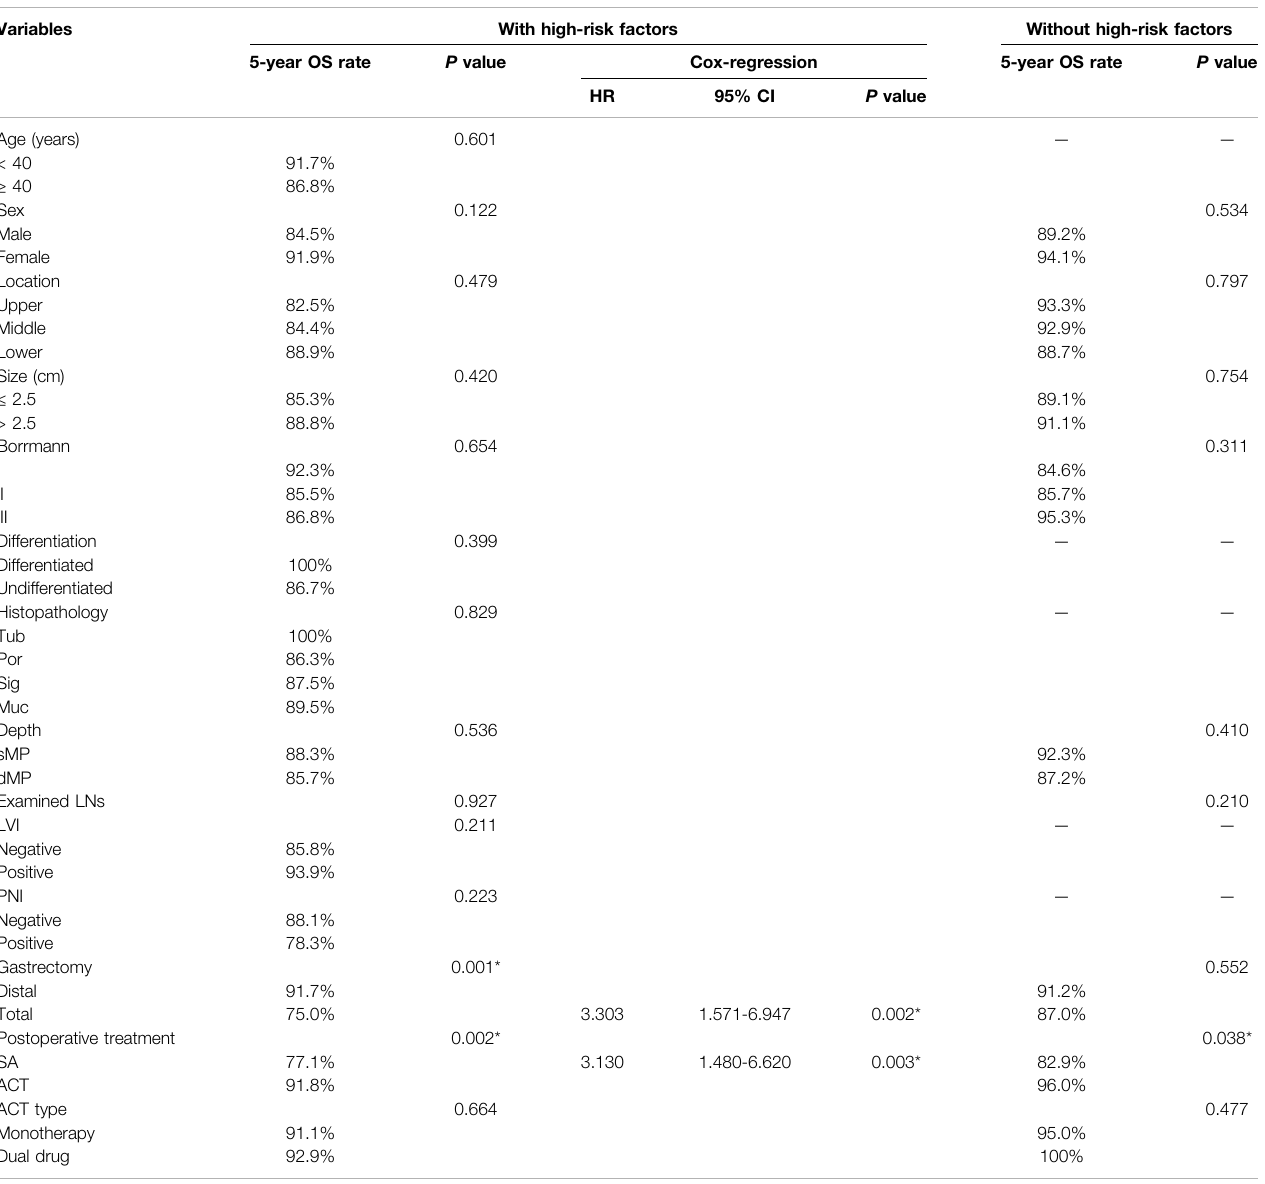
TABLE 3 | Univariate and Cox-regression of overall survival of patients with pT2N0M0 gastric cancer strati fi ed by high-risk factors. Variables With high-risk